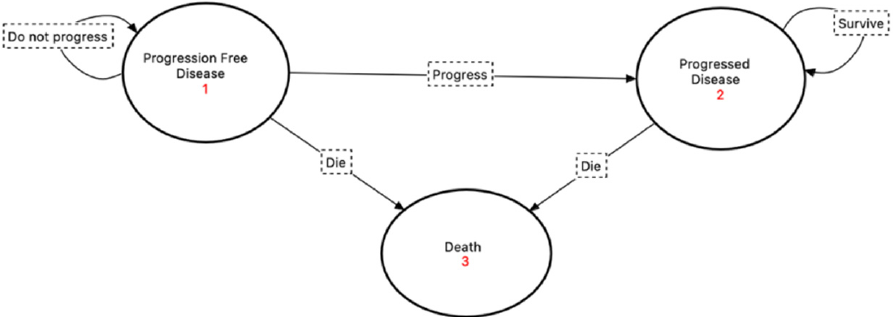
Figure 1. Visualization of the Markov model implemented in the study with the state diagram and their transitions’ pathways.